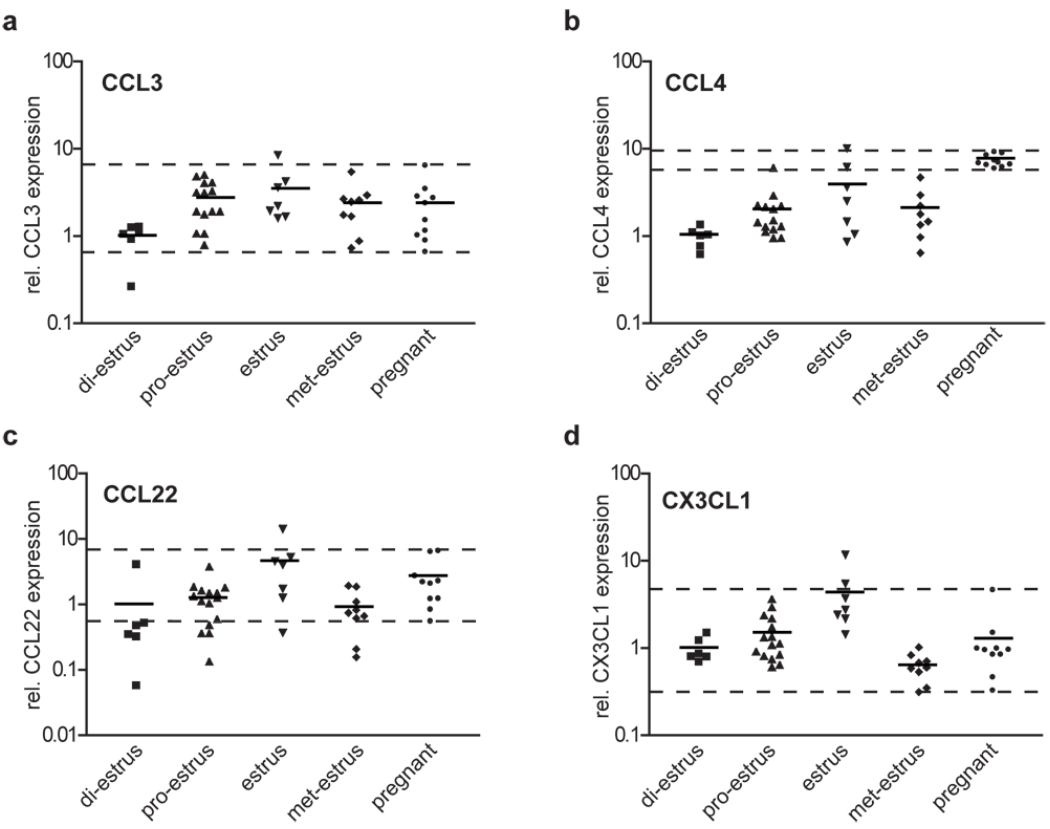
Figure 2. Variation of chemokine expression in the uterus during the mouse estrus cycle and pregnancy. Relative levels of (a) CCL3, (b) CCL4, (c) CCL22 and (d) CX3CL1 were determined by quantitative RT-PCR performed on total uterine mRNA, normalised to HPRT on the same sample set used in Fig. 1. Levels for the 4 estrus cycle phases are shown in chronological order and compared to the levels in pregnant mice. Each point corresponds to one animal. Horizontal bars represent the mean of each data set. Dotted lines indicate the maximal and minimal values detected for pregnant mice.